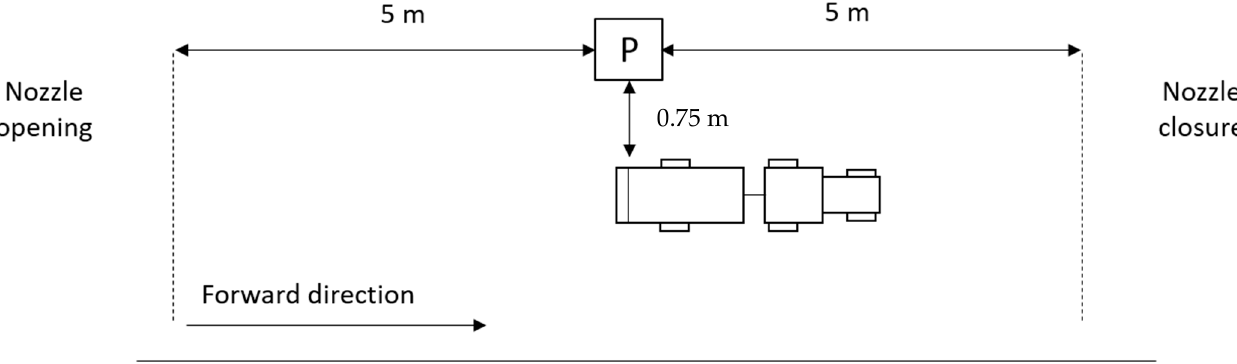
Figure 7. General scheme of the tests (P: Patternator).